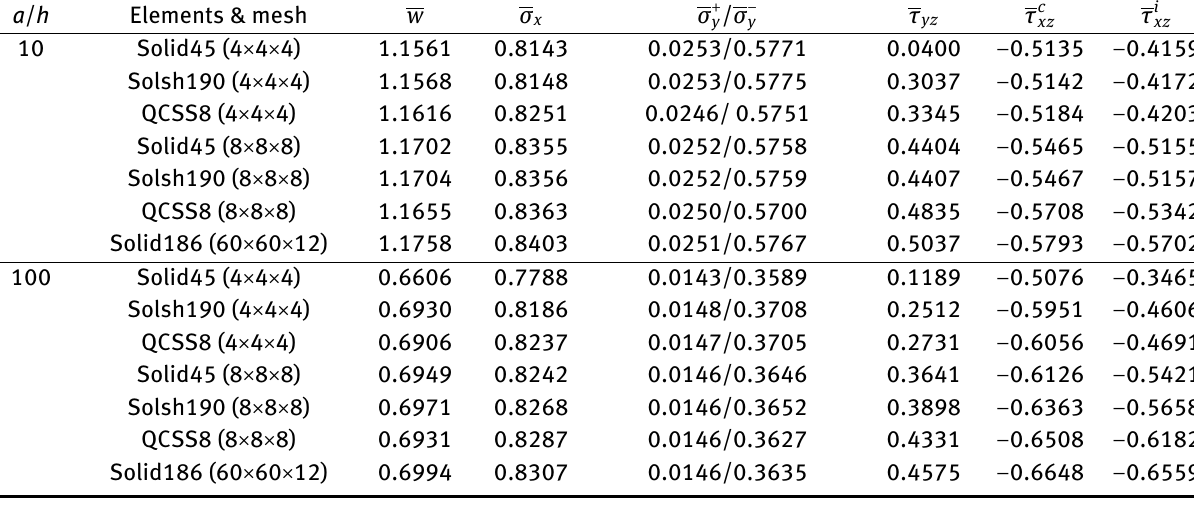
Table 1: Normalized deflections and stresses in a [0/90/90/0] laminated plate under the uniformly distributed load.